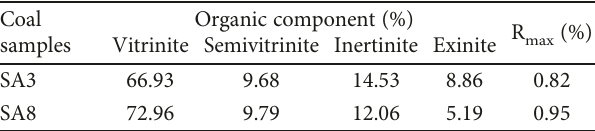
Table 1: Maceral statistics of sampling coal seam [29]. Coal Organic component (%) samples